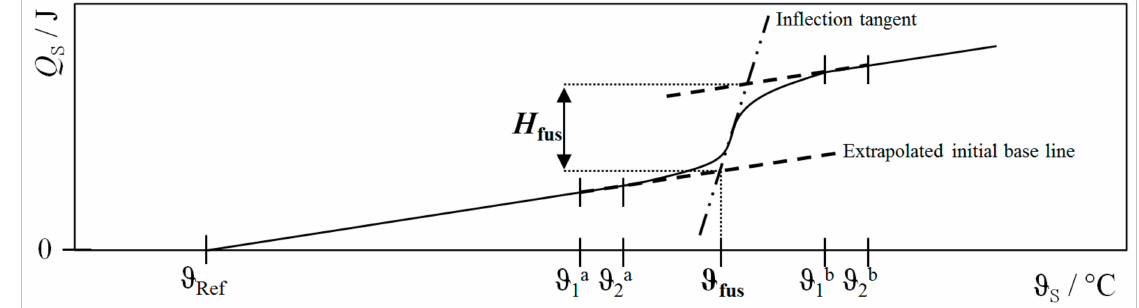
Figure 3. Schematic routine to derive enthalpy of fusion H fus and melting temperature ϑ fus geometrically from Q S